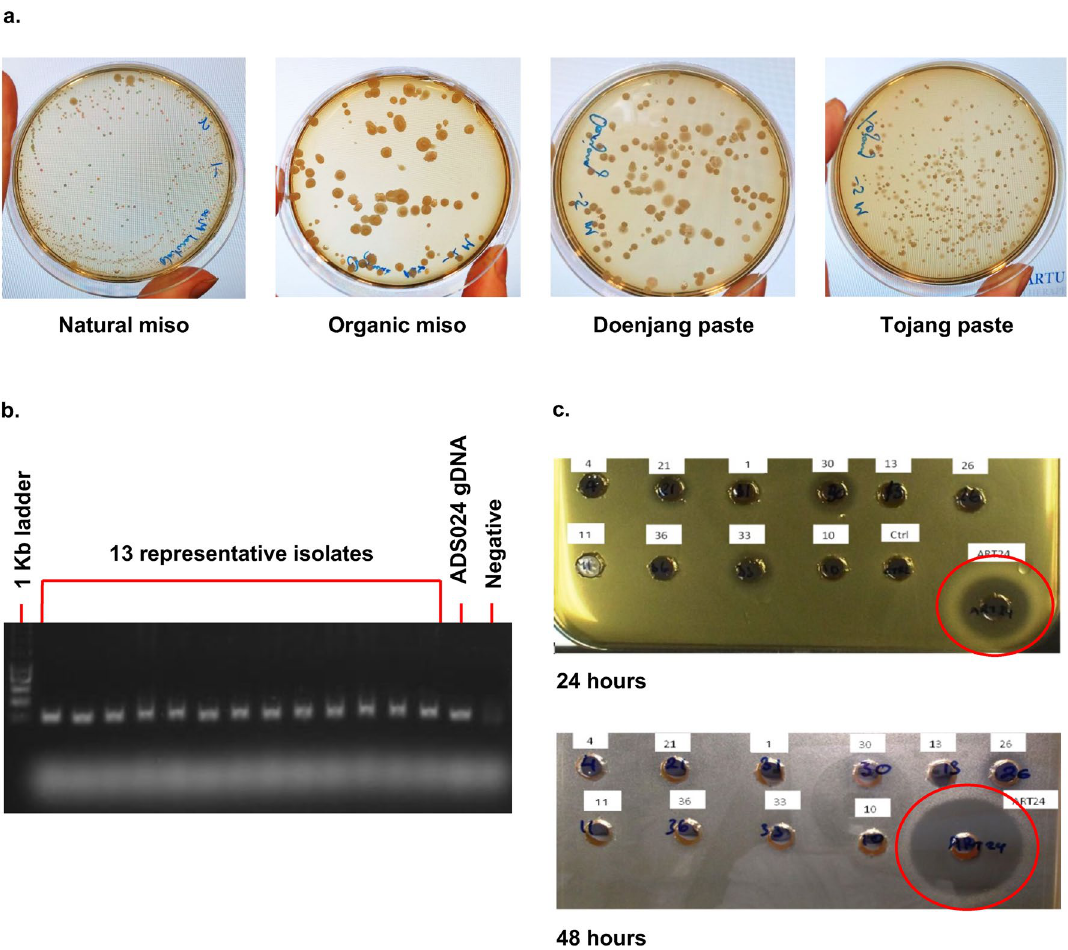
Figure 3. Bacillus -like bacteria can be isolated from fermented foods. ( a ) Representative agar plates of cultures of natural miso, organic miso, doenjang paste, and tojang. B. amyloliquefaciens/B.velezensis were detected only in organic miso and doenjang paste. ( b ) A subset of 13 representative colony PCR amplicons is shown in ( b ). Colony PCR from 13 representative isolates of B. amyloliquefaciens/B.velezensis from fermented foods were compared to ADS024 genomic DNA. Five isolates were selected for whole genome sequencing and confirmed to be B. velezensis. ( c ) Supernatants from food-derived B. amyloliquefaciens operational group members were compared to supernatant from human-derived ADS024 in the well diffusion assay against C. difficile. Only human-derived ADS024 (red circles) displayed clear zones of inhibition after 24 h and 48